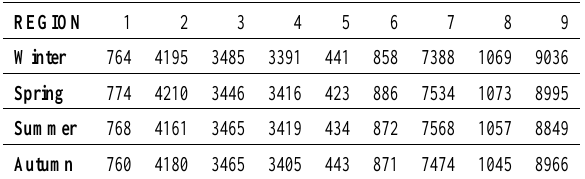
Table 1. Temporal breakdown by season, by month, and by region of the insitu profiles from the Medatlas data set whose minimum depth is 480m